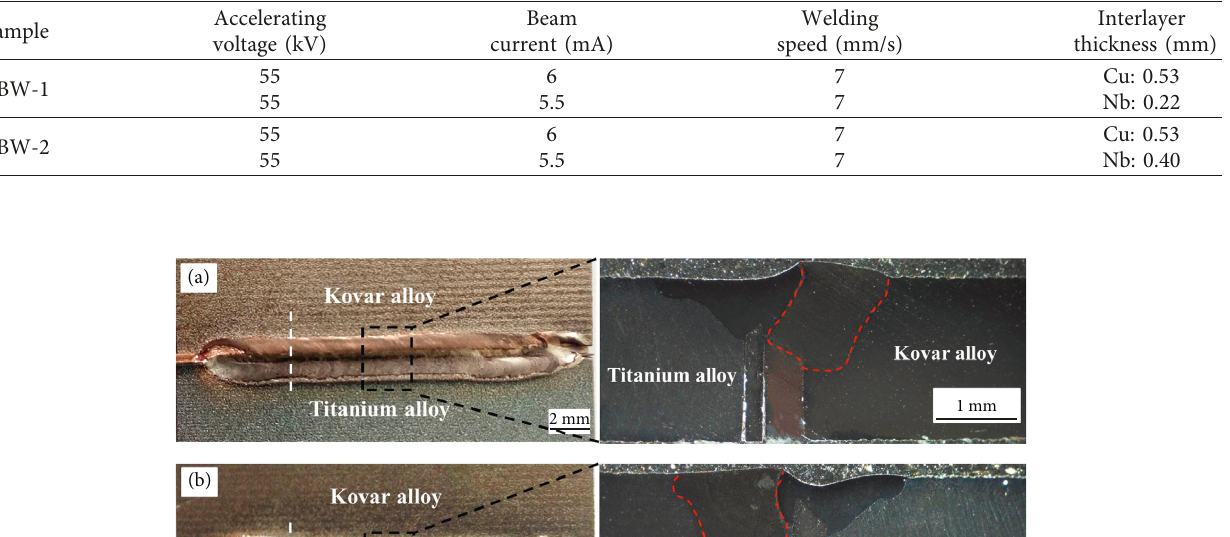
Table 3: Welding parameters used in dual-pass welding.